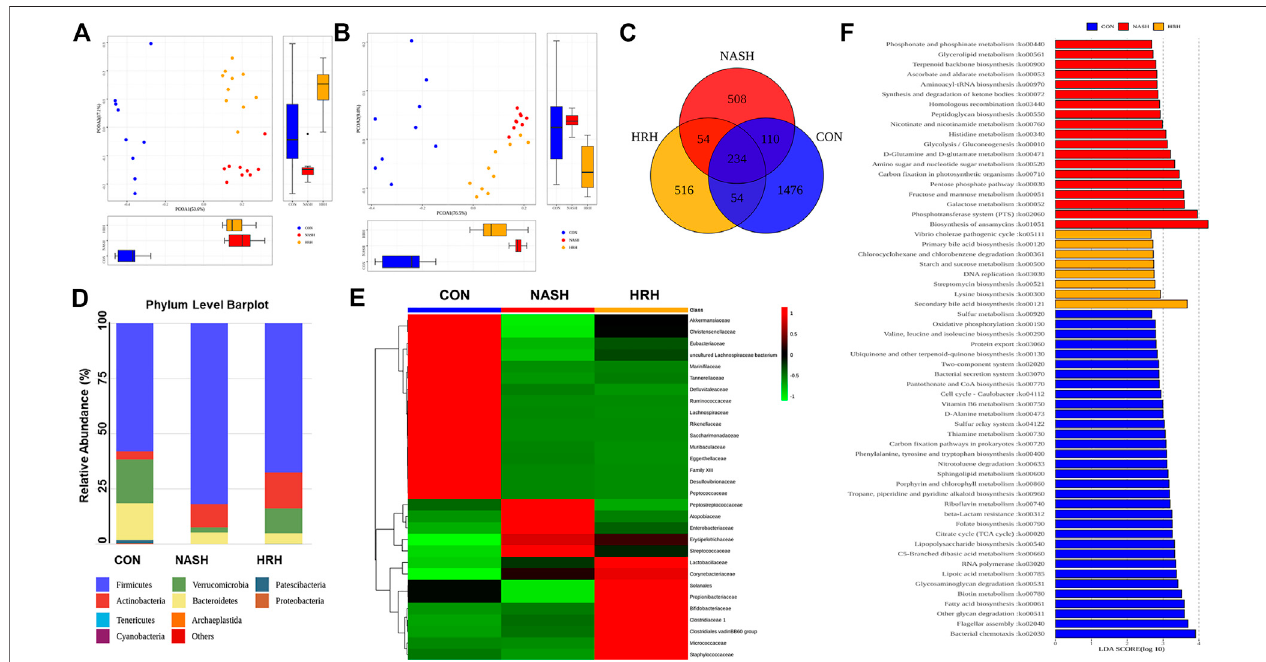
FIGURE 3 | HZRG modulates gut microbiota in NASH mice. (A) PCoA analysis based on the weighted UniFrac analysis of OTUs; (B) PCoA analysis based on the unweighted UniFrac analysis of OTUs; (C) Venn Diagram; (D) Mean Phylum abundance of OTUs; (E) Mean family abundance of OTUs; (F) Pathways that based on PICRUST functional prediction. Data are expressed as mean ± SD of 9 or 10 animals per group.